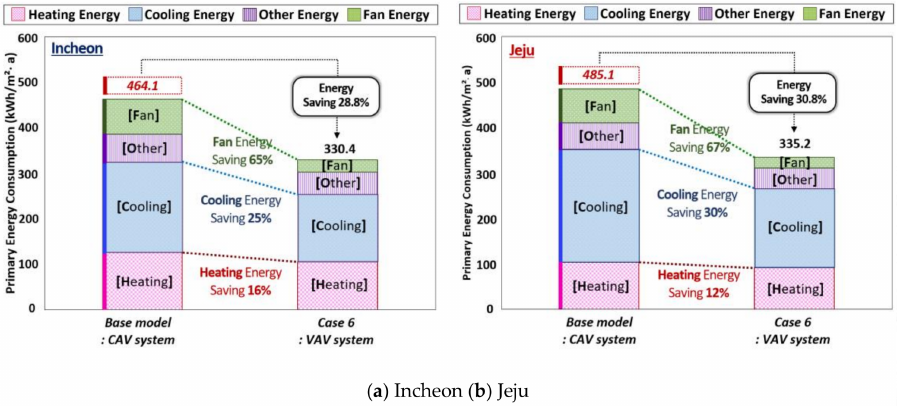
Figure 13. Primary energy consumptions and energy saving potential (%) of Case